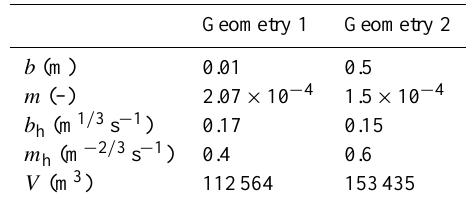
Table 4. Parameters for the two different conduit configurations compared in scenario 4. b is the minimum conduit radius, m the slope of radius increase towards the springs, b h the highest con- duit roughness, m h the slope of roughness decrease away from the spring and V the conduit